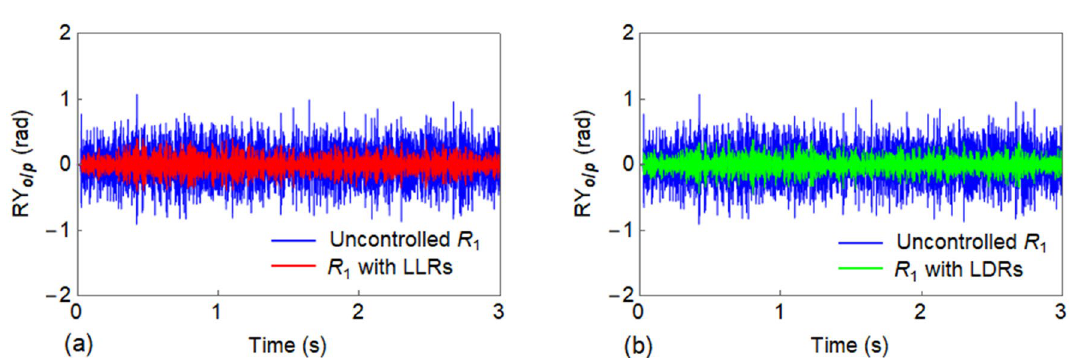
Figure 11. Comparison between the output response ( RY o / p ) of R 1 in the lateral direction: ( a ) uncontrolled R 1 against R 1 with LLRs; and ( b ) uncontrolled R 1 against R 1 with